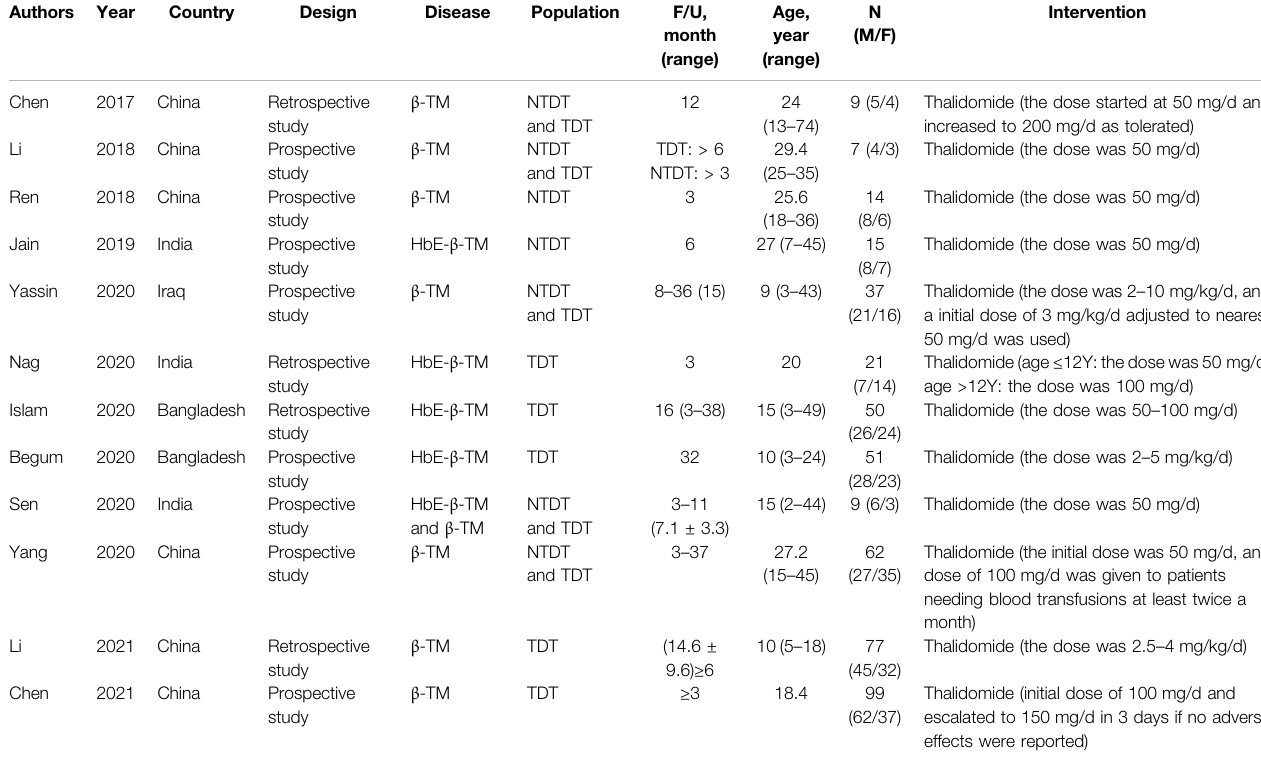
TABLE 1 | Characteristics of the included